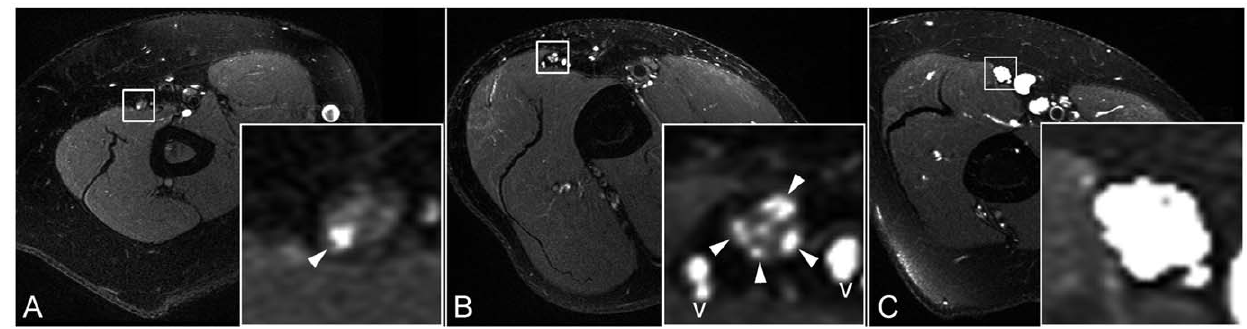
Figure 2. Spectrum of proximal ulnar nerve lesions. T2-w cross-sections through upper arm with ulnar nerve magnifications. [A] shows a restricted lesion involving only one individual fascicle, [B] shows multiple fascicular lesions (arrowheads) not to be confused with adjacent small vessels (v), [C] shows a whole-nerve lesion with severe caliber increase.